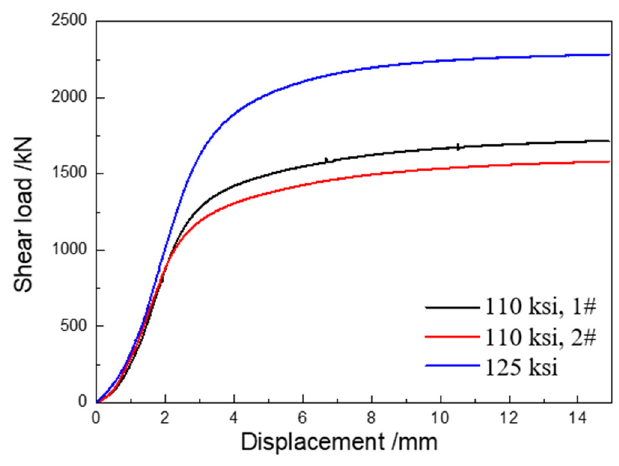
Figure 4. Curve of casing shear load and displacement.